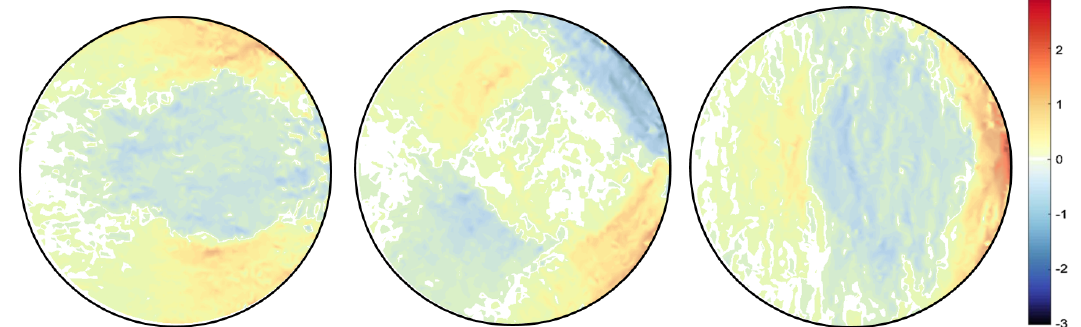
Figure 10. Regularised strain field ε xx , ε xy , ε yy respectively for unstructured mesh type, with S as identity matrix and α = 0.005.